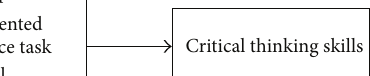
Table 2: WGCTA split half reliability